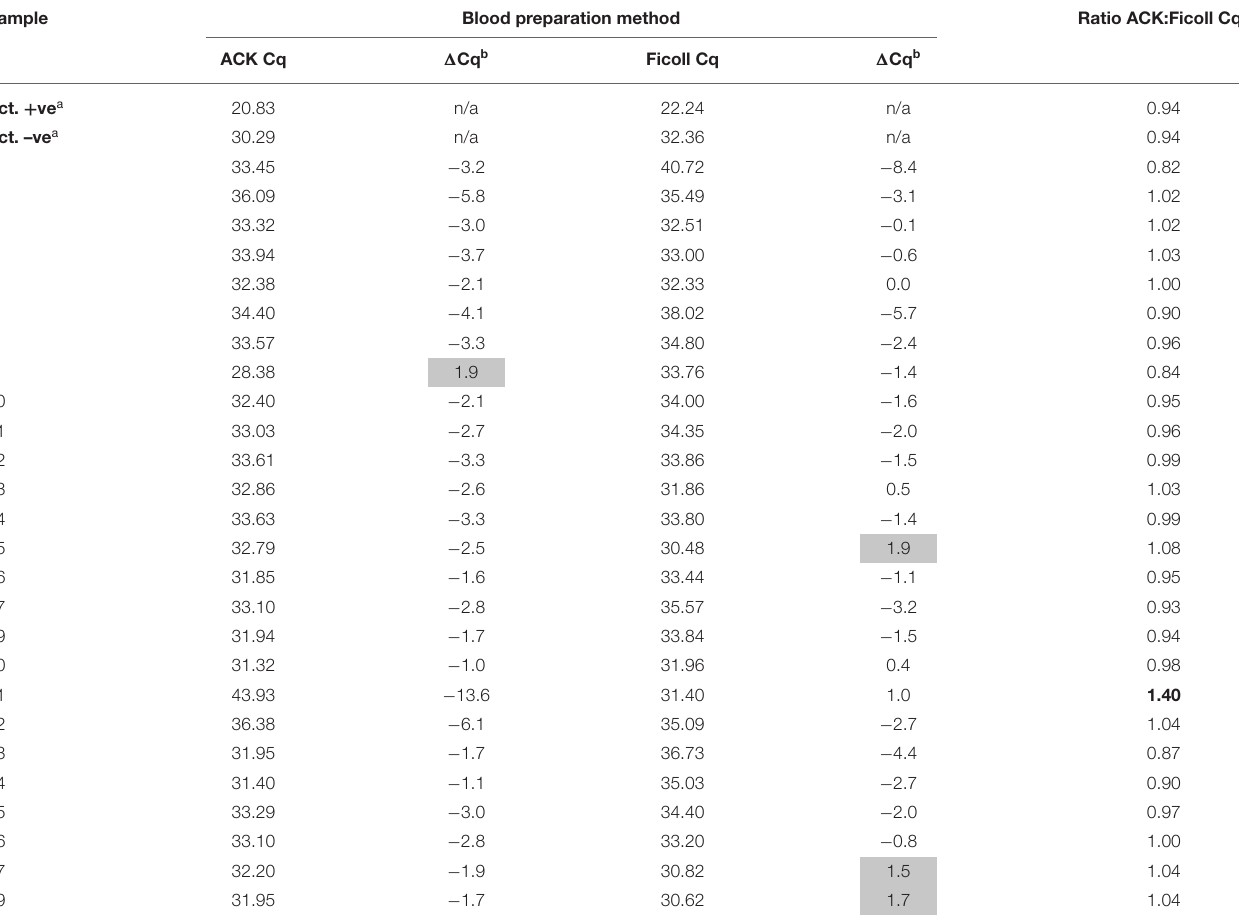
TABLE 1 | Comparison of qPCR result for deer blood samples prepared using Ficoll and ACK methods.